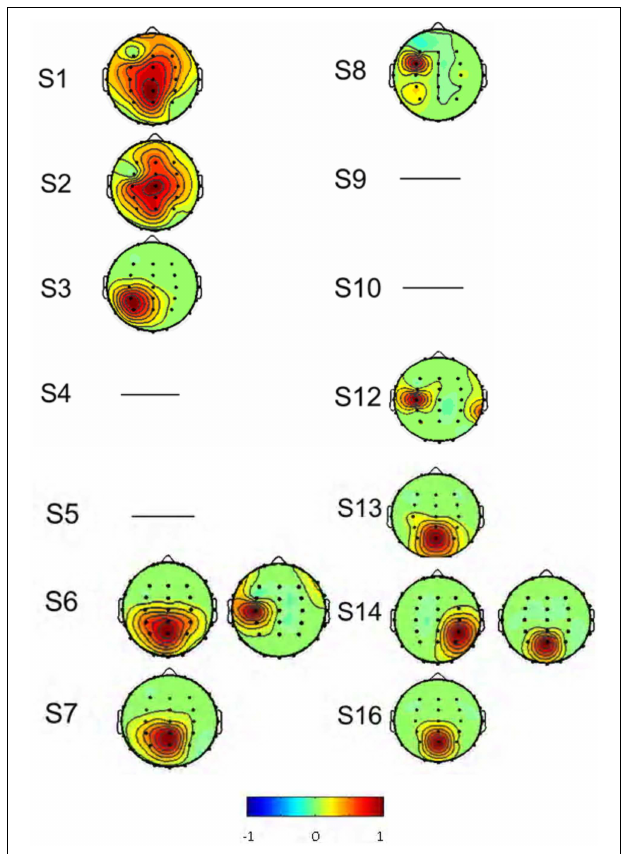
FIGURE 4 | The spatial distribution of the interested source signals from ICA analysis. Results were from 14 of the 16 subjects, and subjects S 11 and S 15 were excluded. No right source components were found in subjects S4, S5, S9, and S10 and the rest subjects had normal source distributions. Signal space distribution was denoted by selected color circles and color intensity (–1 to 1) on the map. Blue represents –1, Red represents 1.